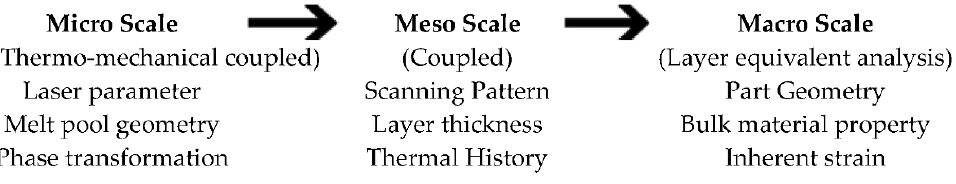
Figure 1. Multi-scale simulation approach in AM distortion analysis.